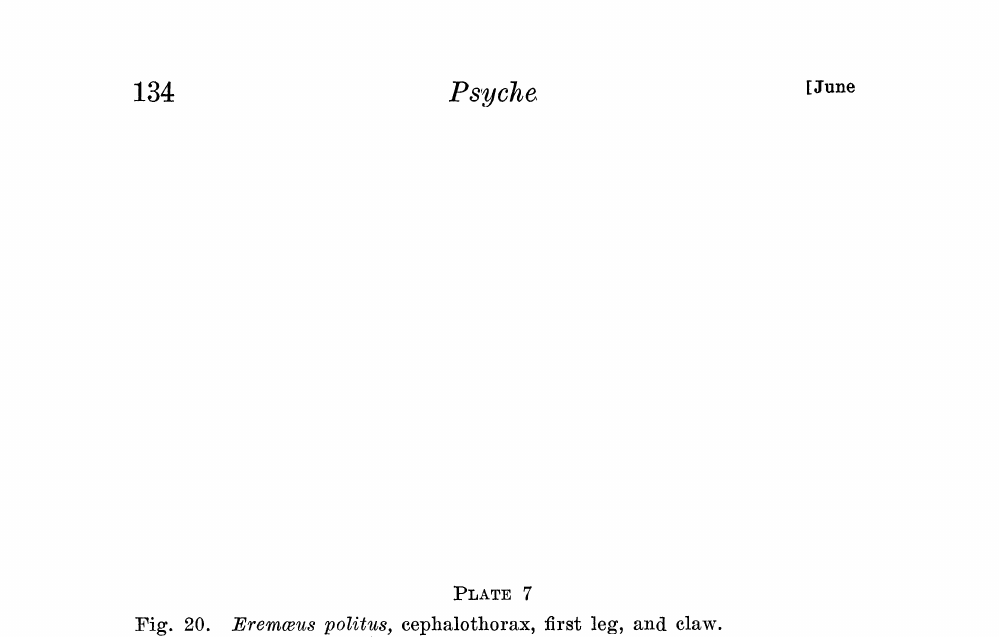
:PLATE 7 Eremeus politus, cephalothorax, first leg, and claw. Fig. 20. Autogncta arnica, renter. Fig. 21. Eremceus politus, renter, and second leg. Fig. 22. Eremobelba gracilior, cephalothorax from below, and fourth leg. Fig. 23. lig. 24. Alloribates singularis, cephalothorax, wing from side, third and fourth legs, and first tibia and tarsus. Fig. 25. Alloribates singularis, venter, and fourth